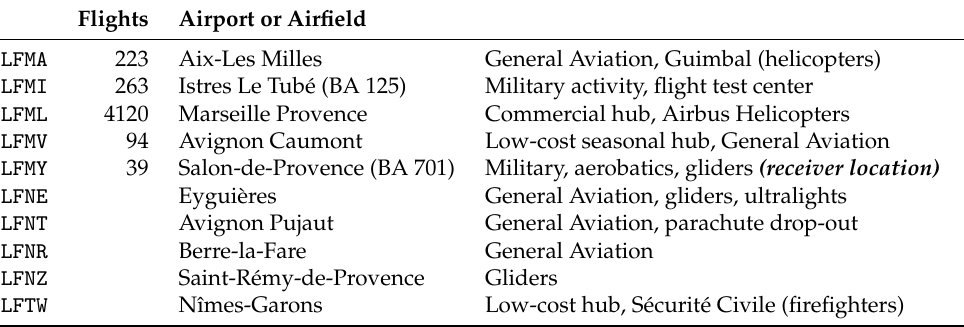
Table 1. The case study spans over many airfields and covers a wide range of aeronautical activities. Flights with ADS-B coverage and tagged as landing or taking-off from these airfields were counted in the appropriate column of the table.